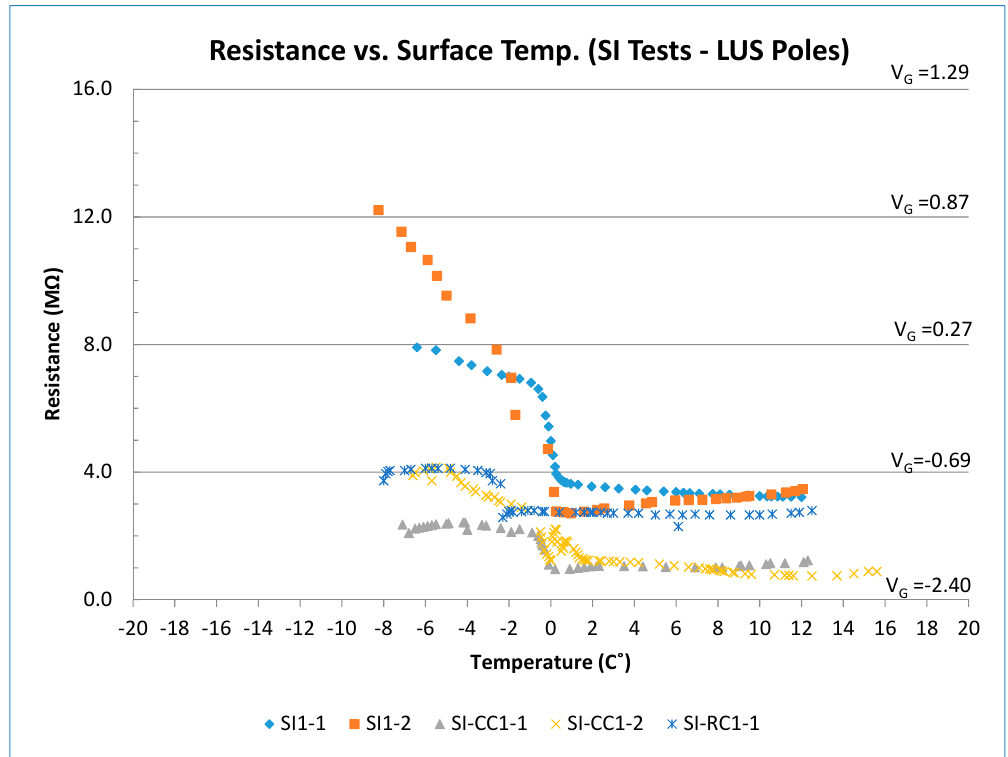
Figure 12. Resistance (and voltage) versus surface temperature for all SI tests (LUS Poles).